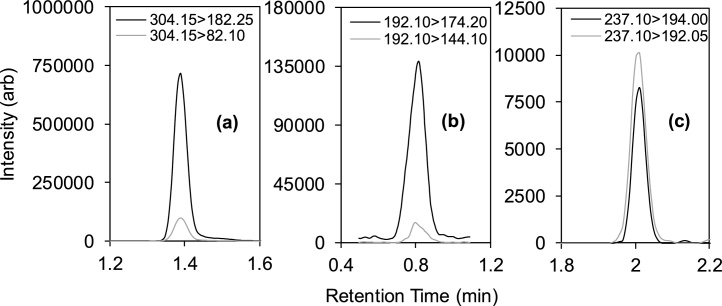
Example MRM chromatograms for selected analytes detected in wastewater samples from June 2019 including (a) cocaine (801 ng L−1, London), (b) 4-MEC (913 ± 12 ng L−1, Mexico) and (c) carbamazepine (30 ng L−1, London).